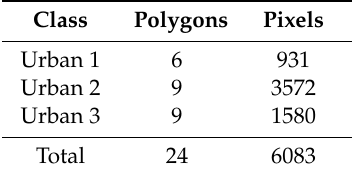
Table 3. Breakdown of the number of training polygons and pixels sampled for each SVM